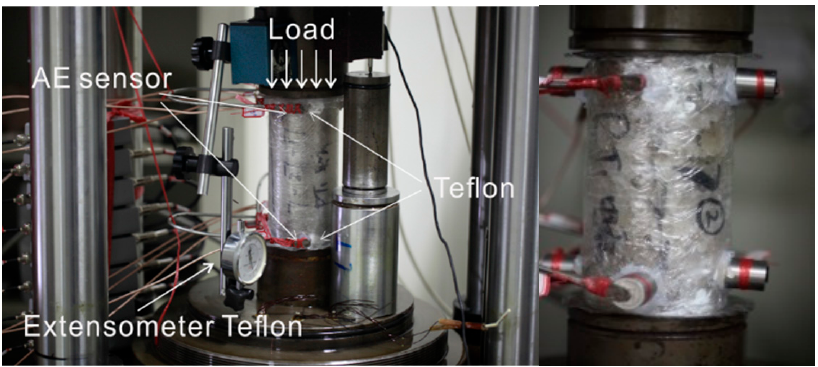
Figure 1. Experimental setup of the creep test of salt rock.